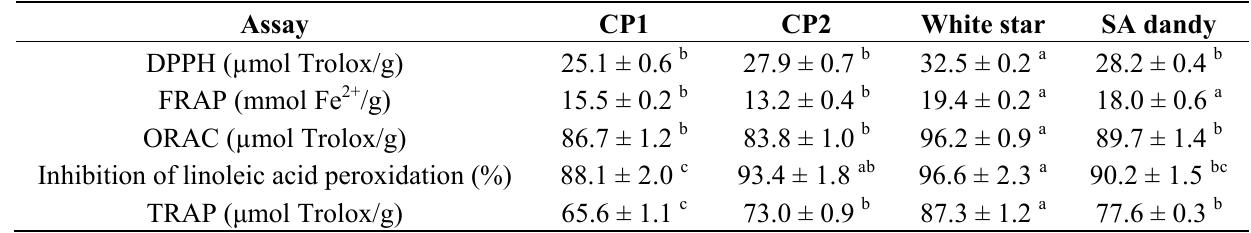
Mean values in the same row having different letters differ significantly ( p <